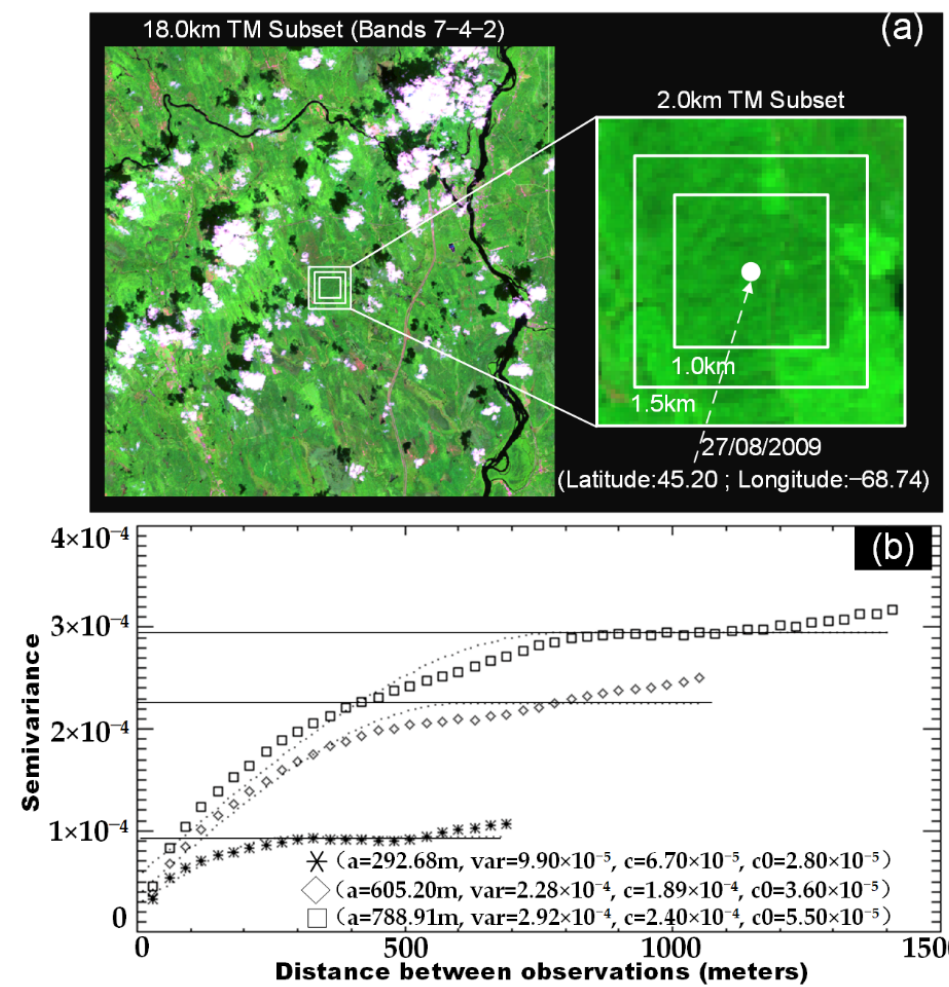
Figure 2. ( a , b ) are examples of using the semivariogram function to assess the homogeneity of the MODIS pixel; ( a ) is view scope of our study site, which are composites of bands 7 − 4 − 2 of the Landsat surface ground reflectance product centered on a MODIS pixel (lat: 45.20 ◦ ; lon: − 68.74 ◦ ); ( b ) is the assessment result, which indicates that the variogram estimator is fitted to a spherical model to derive spatial attributes, including range (i.e., a), sill (i.e., c + c0), nugget effect (i.e., c0), and sample variance (i.e., var).